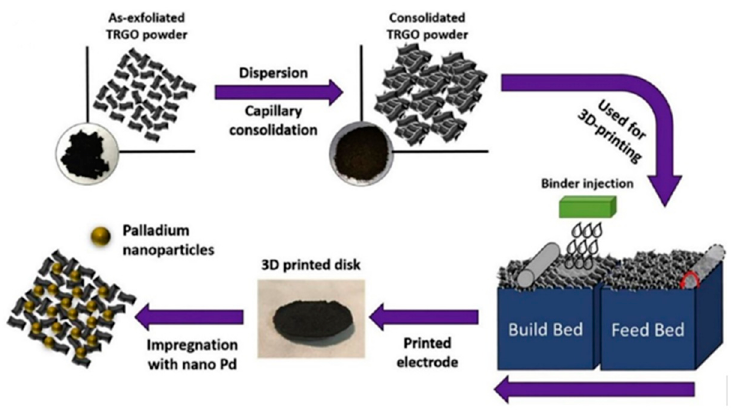
Figure 25. Binder jetting process (adapted with permission from reference [64]).